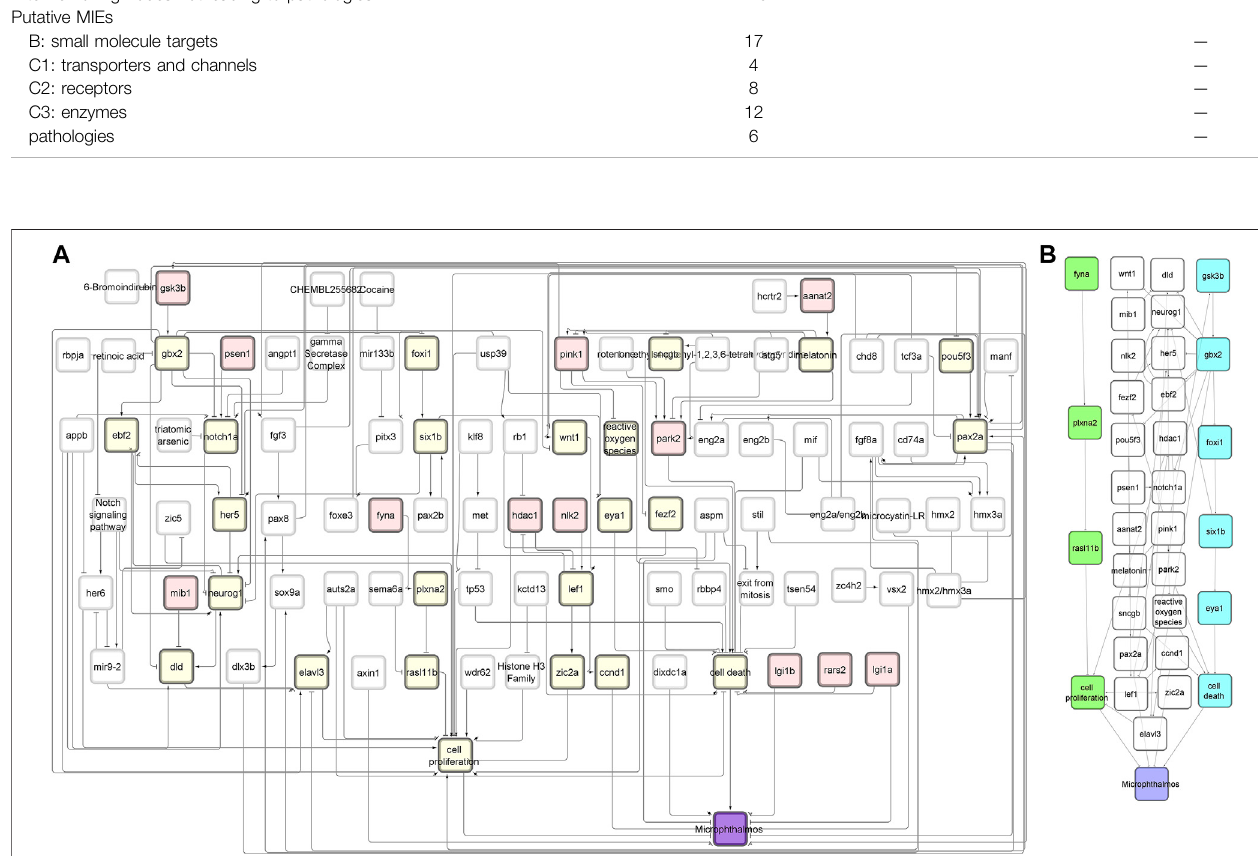
TABLE 2 | The number of simple paths (candidate AOPs) found for each candidate MIE node type/pathology combination. Candidate MIEs Hydrocephalus Microcephaly